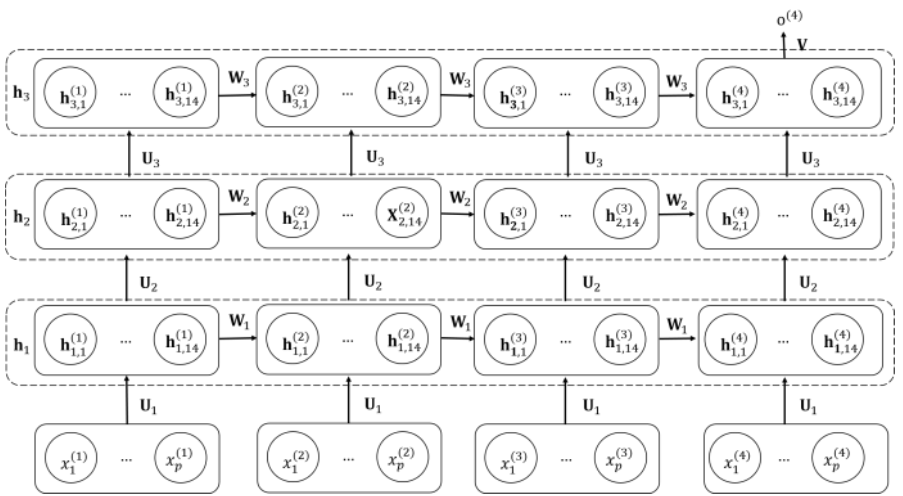
Figure 3. The structure of an RNN (Time Steps 4, Units 14 and Layers 3).